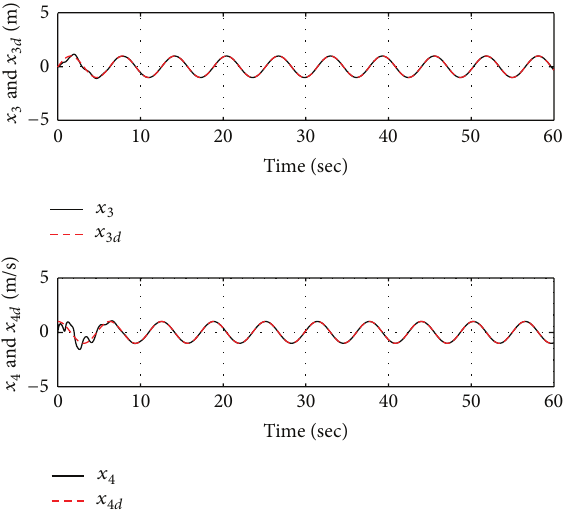
Figure 3: The tracking performances of 𝑥 and ̇𝑥 .